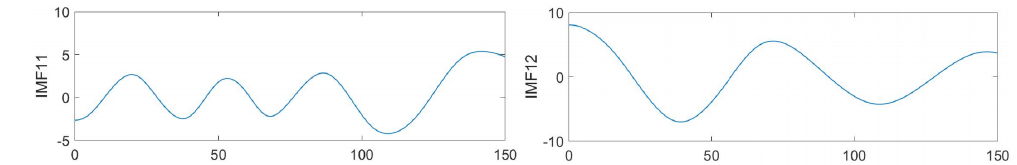
Figure 7. IMF Component Statistical Curve after MEEMD decomposition. We perform spectral analysis on each of the obtained IMF components in order to observe the frequency domain distribution of the signal in all components. The spectrum analysis results are shown in Figure 8 (the horizontal axis of the curve is in Hz).